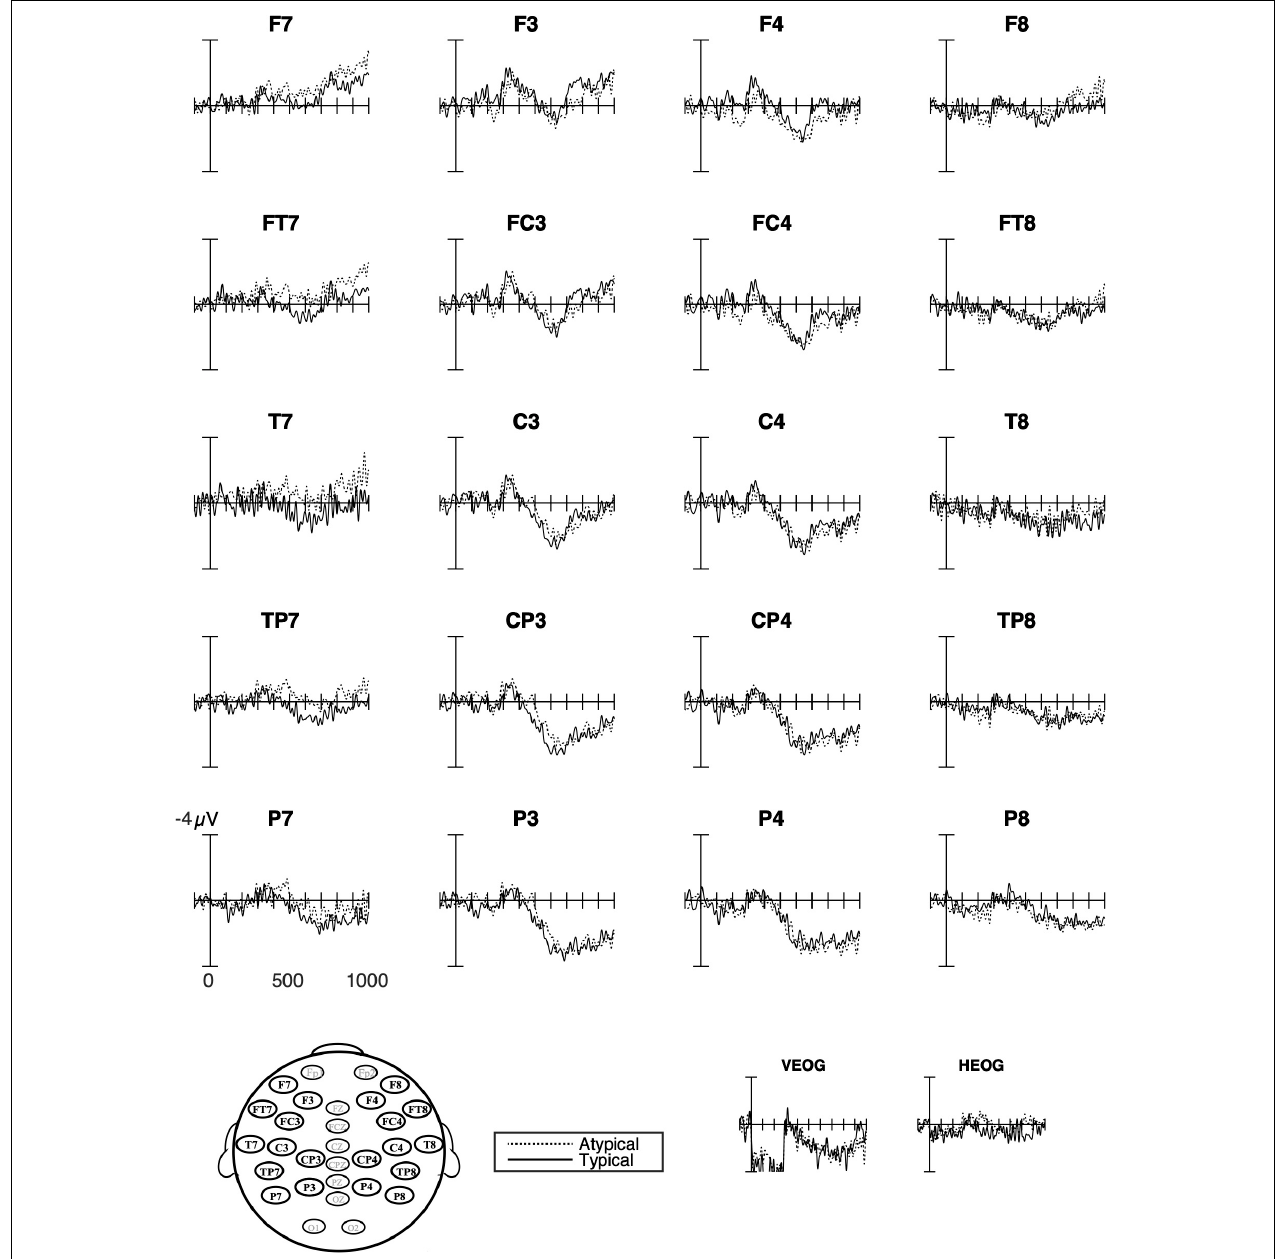
FIGURE 7 | Grand average ERPs for Swedish native speakers. The response to typical verb use (number of trials in the bin, n = 429) as solid lines and to atypical verb use ( n = 428) as dashed lines. The waveforms suggest a left lateral negativity that was strongest for the atypical use of placement verbs followed by a positivity that did not vary with